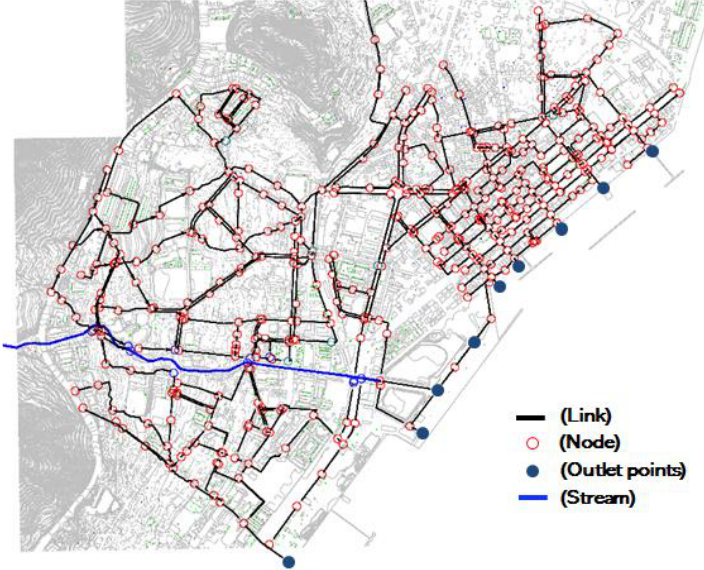
Figure 4. Hydraulic input data (i.e., link, node, and outlet points) of SWMM in Changwon City.